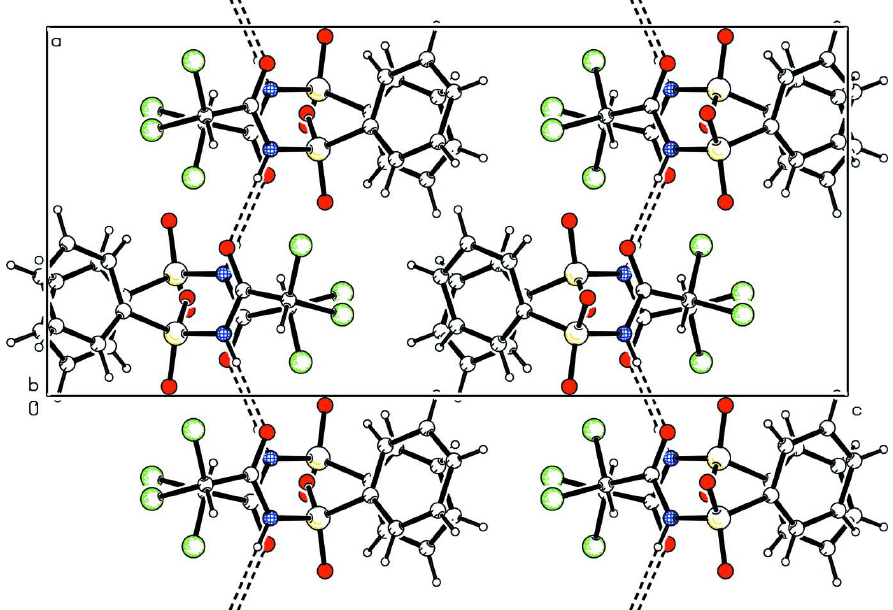
Molecular structure of (I), showing the atom labeling scheme and displacement ellipsoids at the 50% probability level.